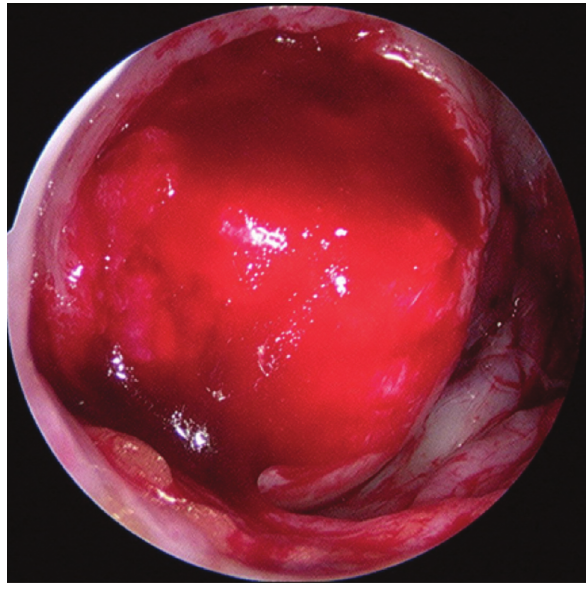
Fig. : Arthroscopy image. BST-CarGel stable in cartilage